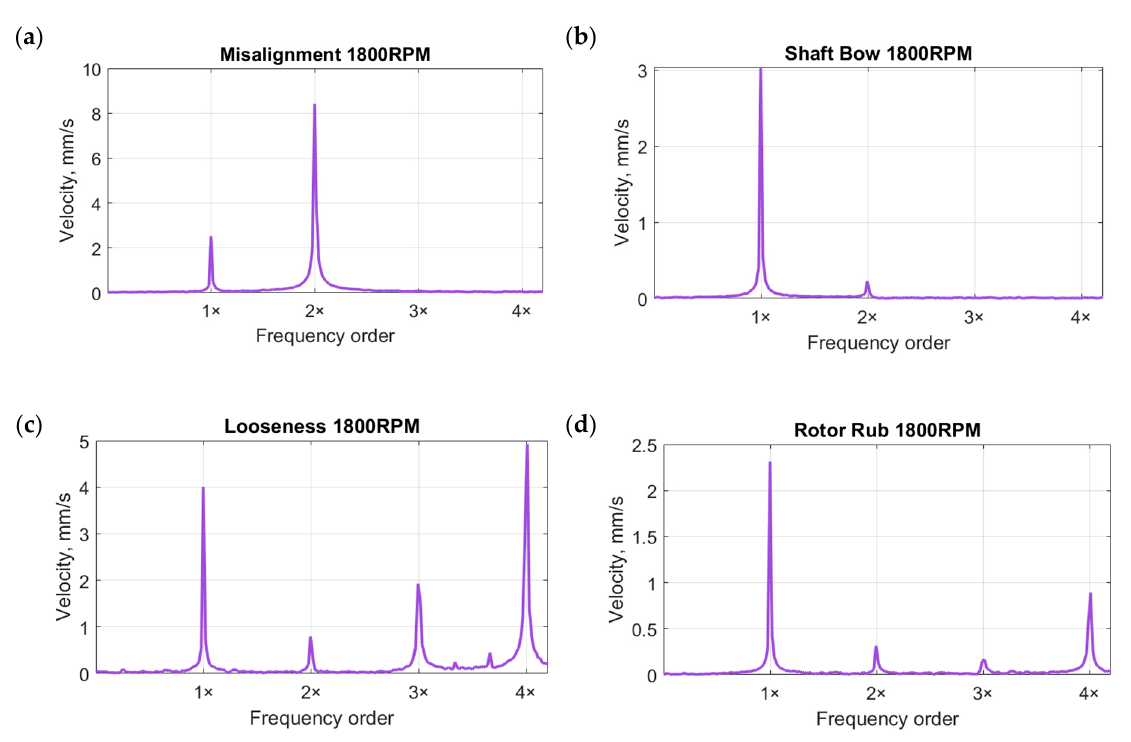
Figure 8. Velocity spectrum plots from data generated in the FE model at 1800 RPM, at B3 location. ( a ) Misalignment; ( b ) Shaft bow; ( c ) Looseness in pedestal; ( d ) Rotor rub.